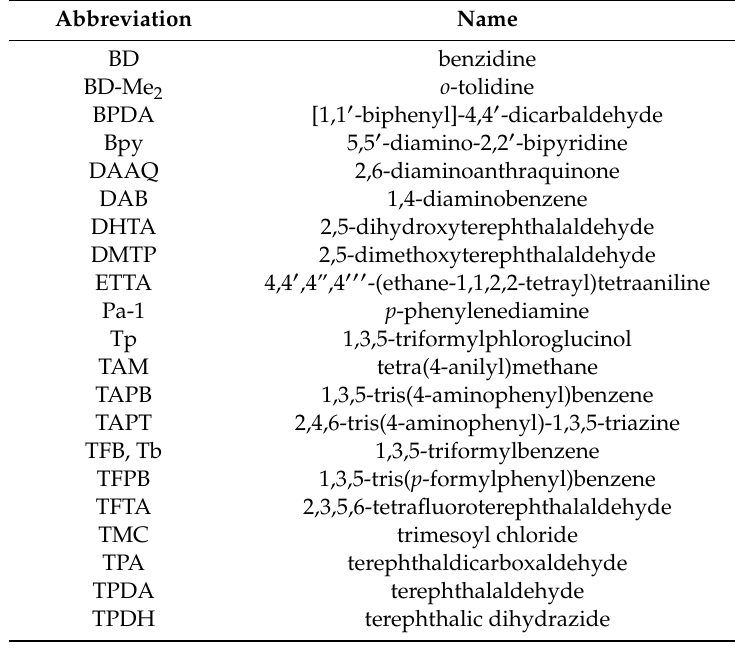
Table 1. Abbreviations for commonly used covalent organic framework (COF) building